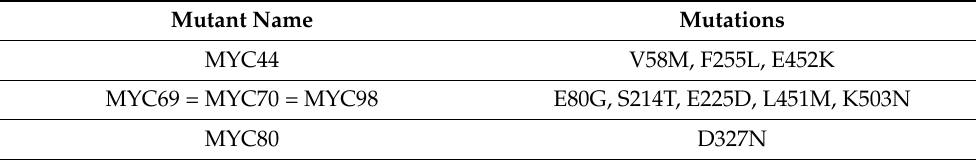
Table 1. Identified mutations of mutants with IF > 2.